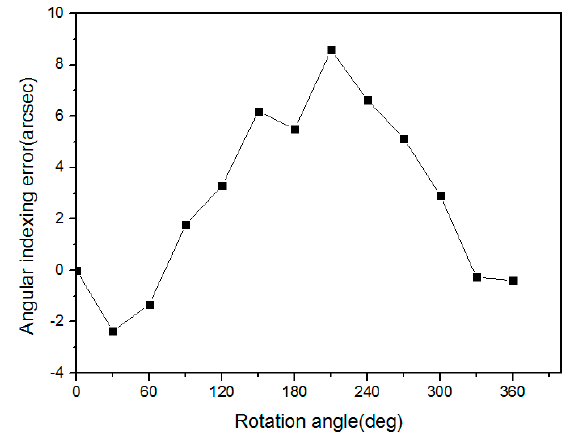
Figure 12. Measured angular indexing error of the mandrel.